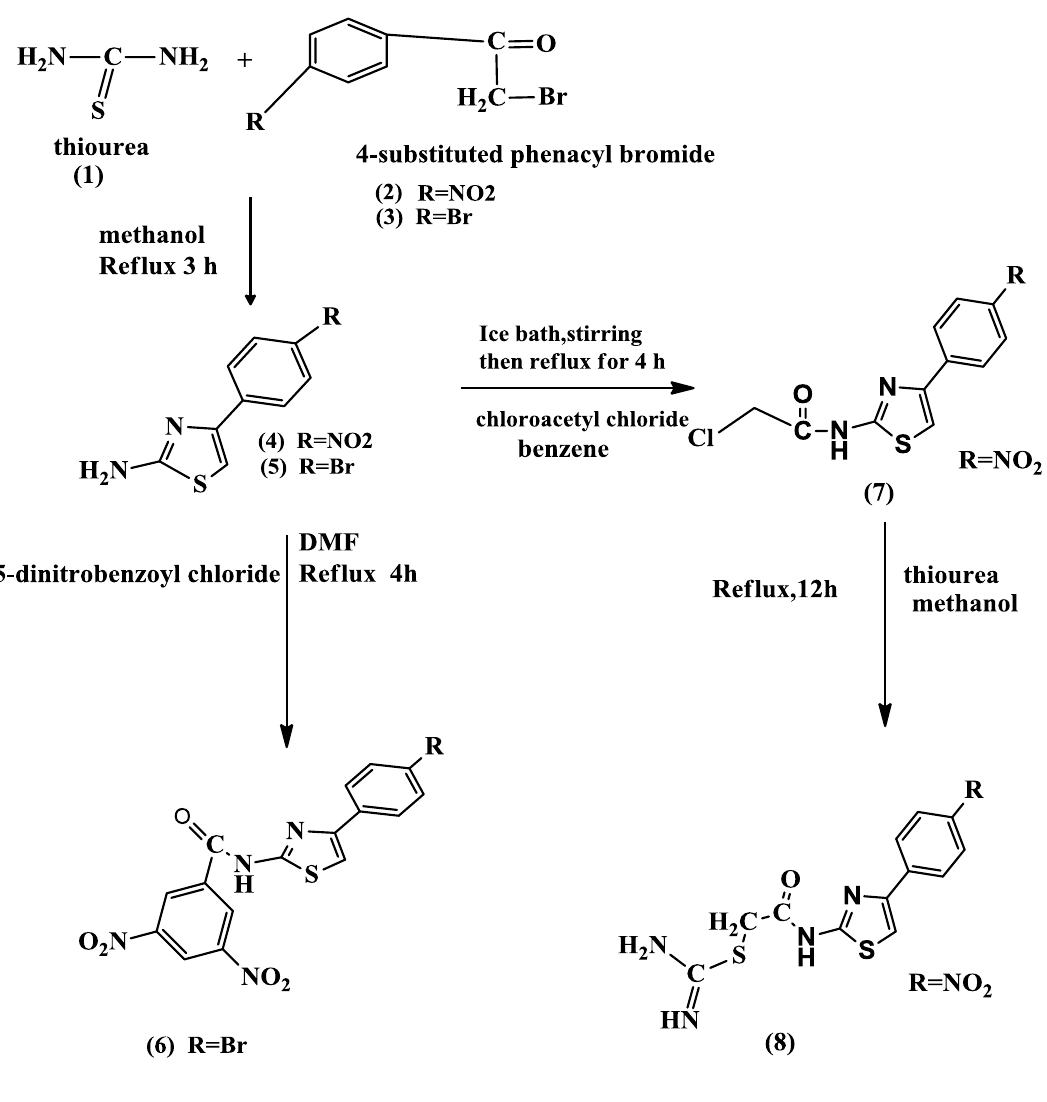
Scheme 1. Synthesis of titled thiazole derivatives